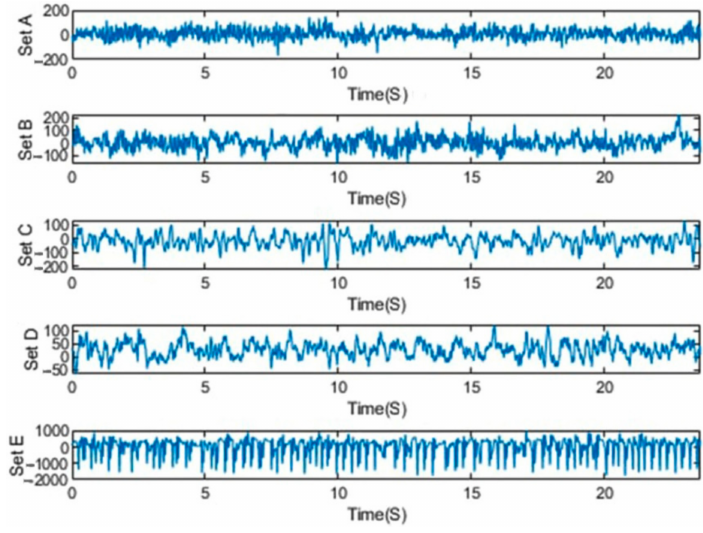
Figure 2. Exemplary EEGs from five datasets.